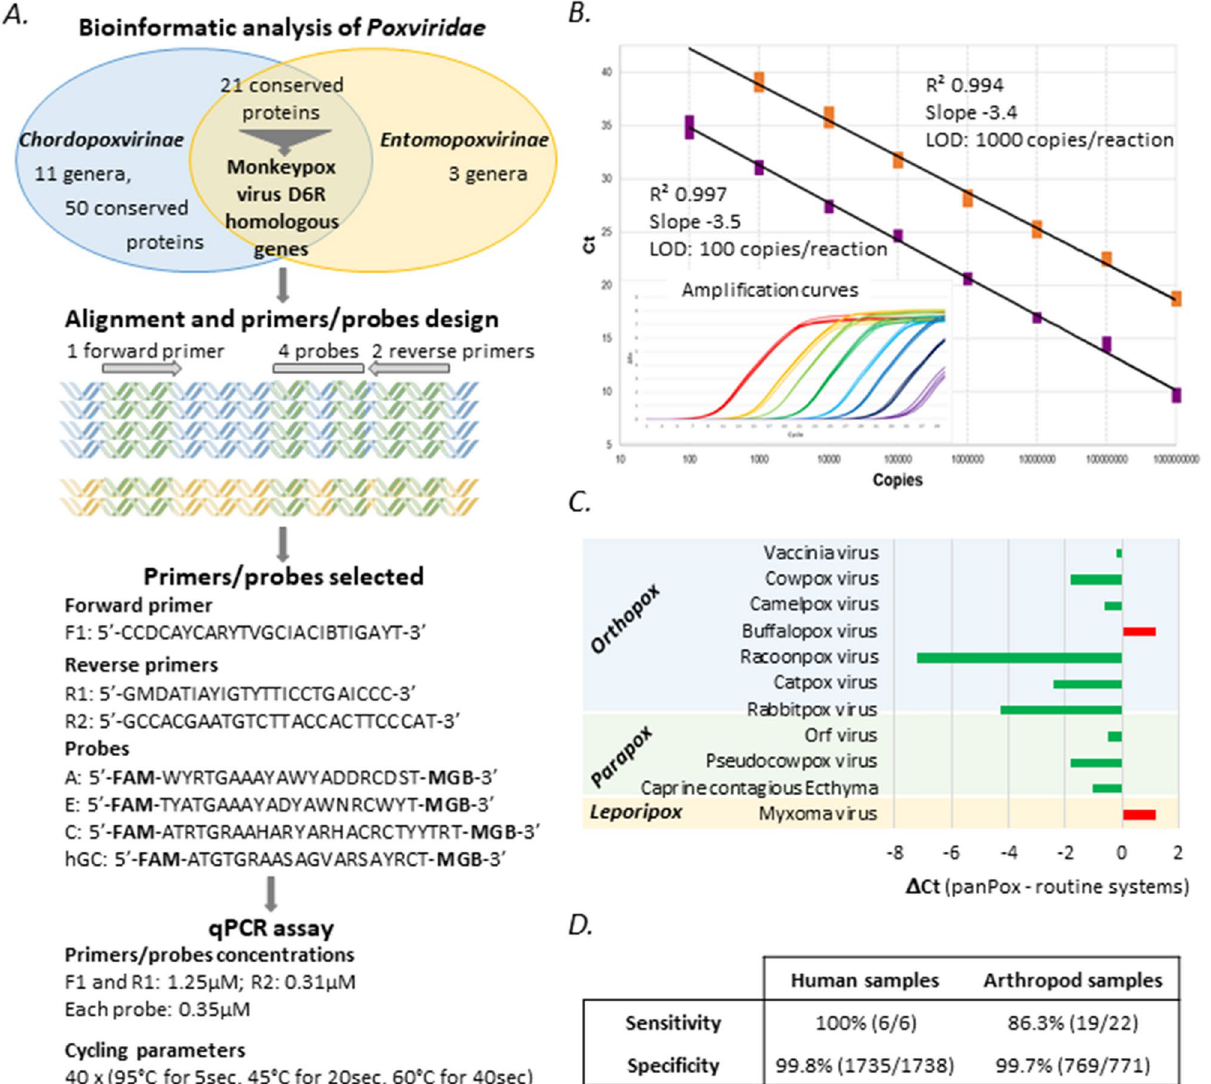
Figure 1. Development of a panPox real-time PCR system. ( A ) Workflow of panPox qPCR assay design. The bibliographic and bioinformatic analysis enables the identification of conserved genes between Chordopoxvirinae and Entomopoxvirinae . Protein blast of Chordopoxvirinae sequences on Entomopoxvirinae database identified 21 conserved proteins. Alignment of candidate genes (highest Blast scores) facilitated the design of a qPCR system combining 1 forward and 2 reverse primers and 4 probes and targeting the Monkeypox virus D6R gene and homologs. The DNA icon was obtained from the Pixabay image bank (mcmurryjulie). ( B ) Limits of detection and reproducibility examples. DNA standards corresponding to the Bovine papular stomatitis virus (BPSV) (orange squares) and Monkeypox virus (purple squares) are shown. The parameters of the standard curve and the limit of detection (LOD) are described next to the standard curve. The insert shows the amplification plot of Monkeypox virus standards at 10 9 (red), 10 8 (yellow), 10 7 (light green), 10 6 (dark green), 10 5 (light blue), 10 4 (dark blue), 10 3 (black) and 10 2 (purple) copies/reaction repeated in quadruplicate. ( C ) Comparison of the panPox system against Myxoma-specific or panOrthopoxvirus and panParapoxvirus qPCR systems (detailed in Supplemental Methods). The results are expressed as Ct value differences between panPox and routine systems. ( D ) Sensitivity and specificity description on a large panel of human and arthropod